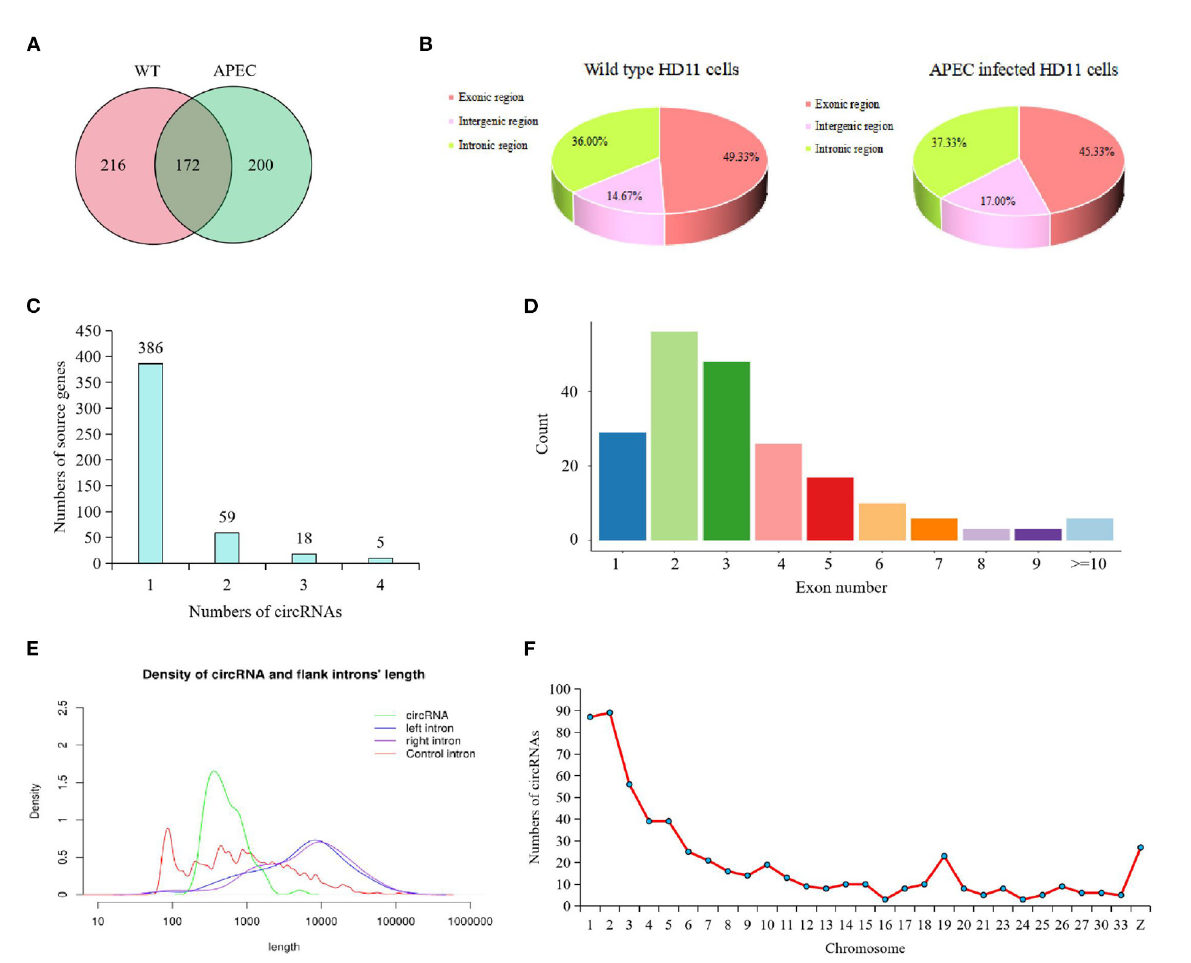
FIGURE1 Characterization of circRNAs identified in chicken HD11 cells. (A) Venn diagram presenting the amount of circRNAs in wild type HD11 cells (WT) and avian pathogenic E. coli infected HD11 cells (APEC). (B) Types of circRNAs in wild type HD11 cells and avian pathogenic E. coli infected HD11 cells (APEC). (C) The analysis on alternative circularization of the identified circRNAs for different source genes. (D) Distribution of amount of circRNAs derived from different number of exons. (E) Length range distribution of the identified circRNAs. (F) The distribution of circRNAs on the